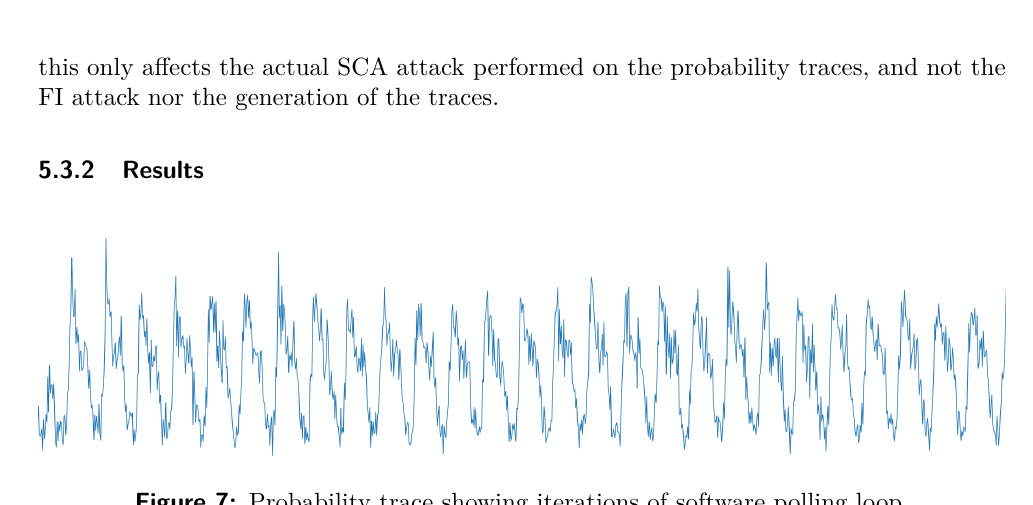
Figure 7: Probability trace showing iterations of software polling loop.